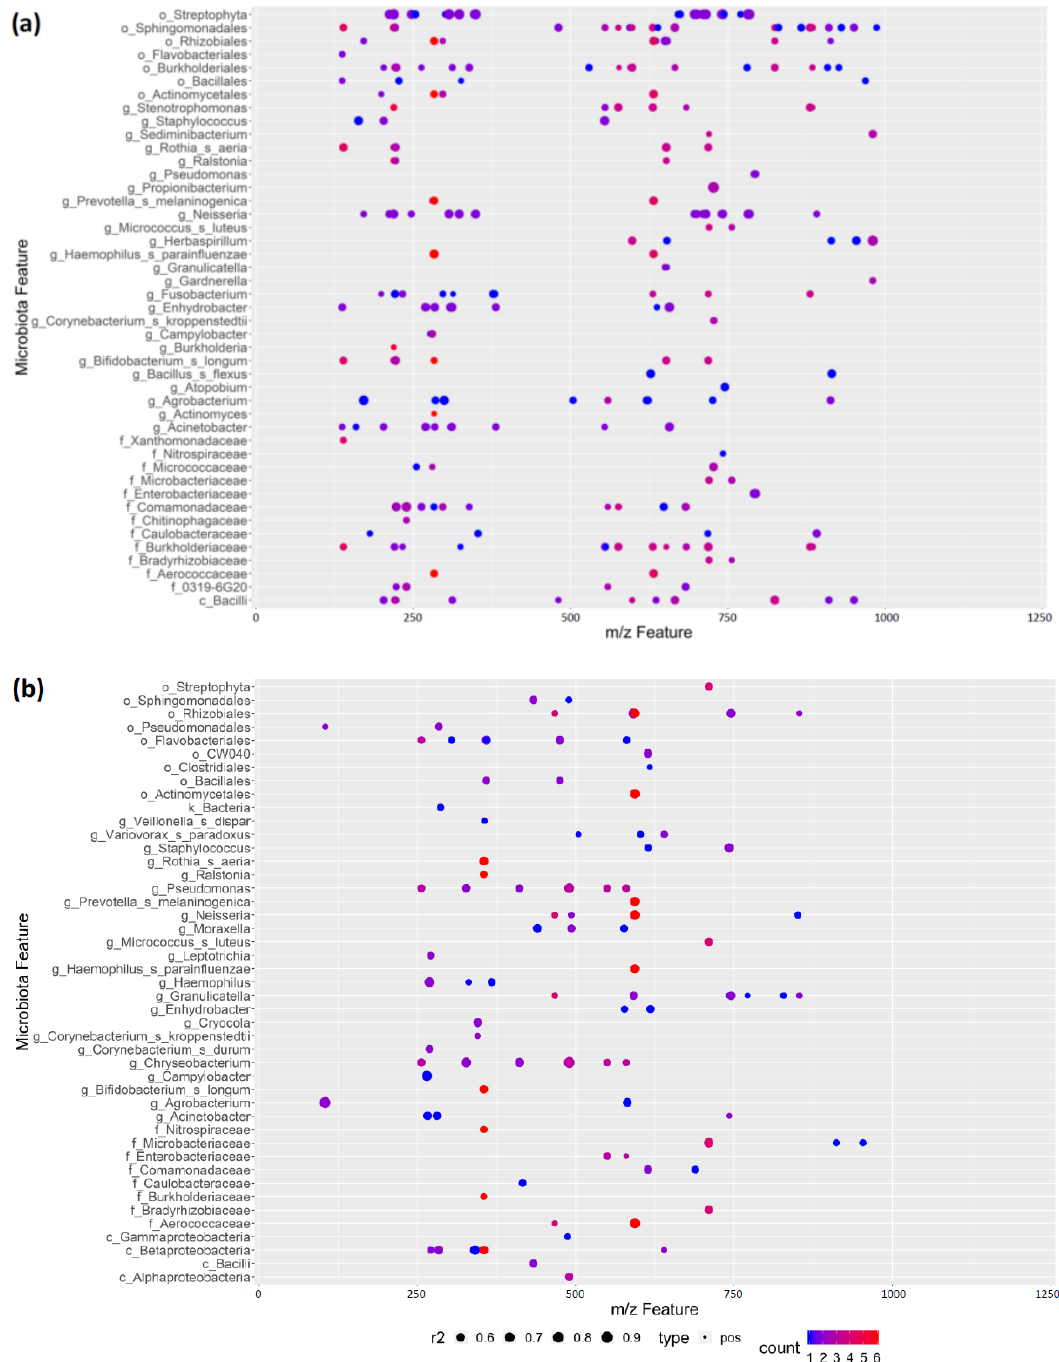
Figure 5. Significant positive correlations between rapid evaporative ionisation mass spectrometry (REIMS) and microbiome features. Pearson’s correlation coefficient was used to identify significant correlations ( p value below 0.05) between microbiome and metabolomic features using ( a ) negative ion detection mode and ( b ) positive ion detection mode REIMS data. Microbiome features are shown to finest taxonomic resolution achieved on y-axis and REIMS features as a mass-to-charge ratio on x-axis. Size of data point indicates strength of correlation feature and colour indicates the total number of significant correlations for that REIMS feature against microbiome features. Only positive correlations were identified in this analysis. A total of 46 human milk replicates are represented in this figure.